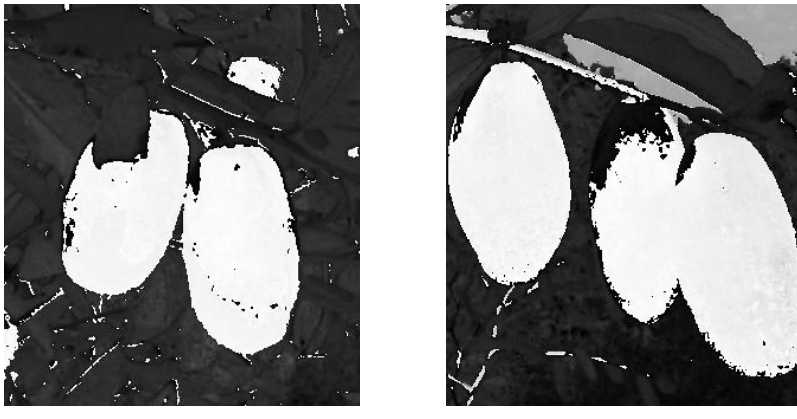
Figure 12. Rotary image of hue.